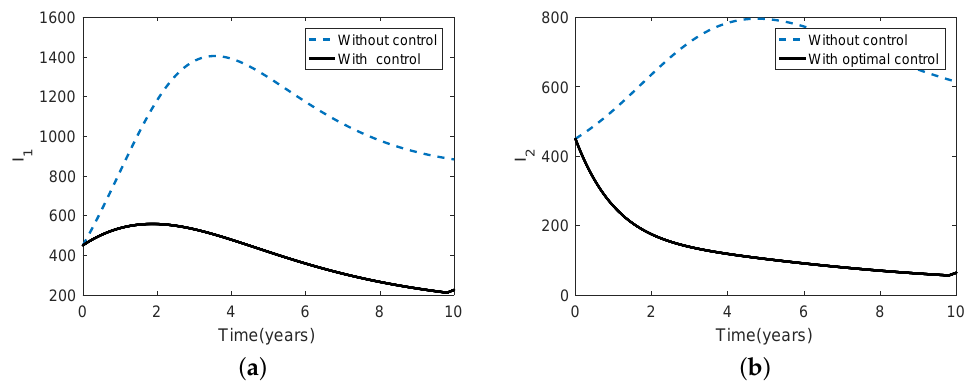
Figure 9. Numerical illustrations demonstrating the impact of optimal intervention strategies on controlling the long-term brucellosis dynamics for scenario 2 under strong asymmetric coupling ( a ) the numbers of infected animals in patch 1 ( b ) the numbers of infected animals in patch 2. In all the figures the dotted blue and solid black curves represent the infected population, without and with control, respectively.